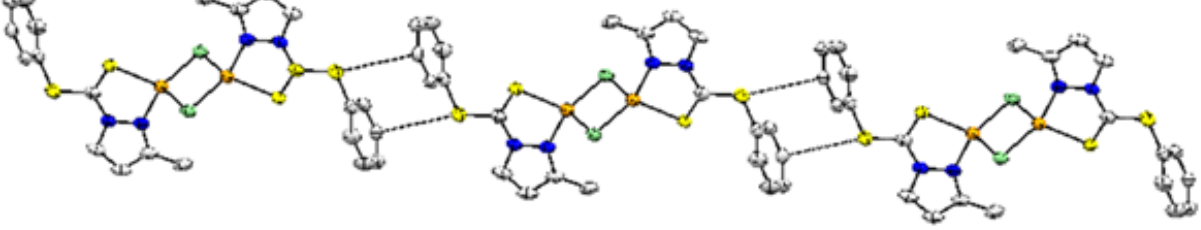
Figure 4. 1D Supramolecular structure of 2 stabilized by C(p) ⋯ S interaction, with a separation dis- tance of 3.491 Å. Color scheme: Cu = orange; Cl: green; S = yellow; and N = blue.